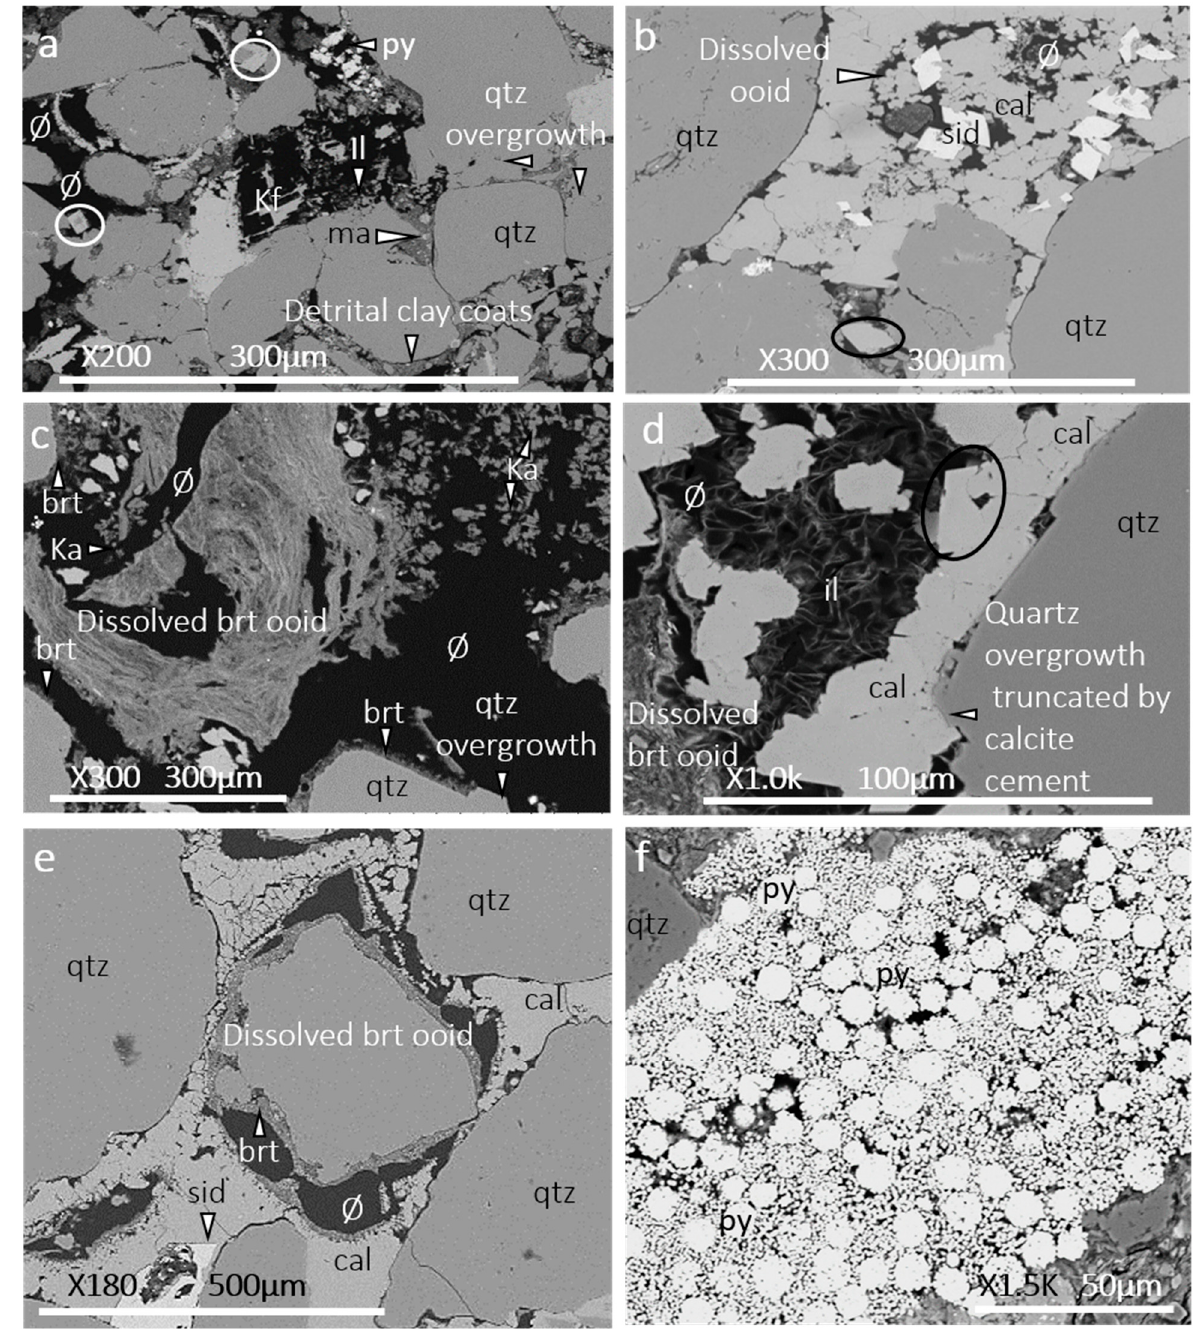
Figure 10. ( a ) BL5 (2211.6 m MD): altered K-feldspar (centre) and dissolved Fe-ooid (top-left) with some compaction to the top-left. Grain contacts show close-packing texture at the centre-right adjacent to detrital clays. ( b ) PW3 (1091.4 m MD): shows where calcite and siderite have replaced a dissolved ooid (top) with the relic of the ooid still visible at the top-right and bottom-left corners of the dissolved grain outline. ( c ) PW3 (1085.1 m MD): relics of a Fe-ooid can be seen in the middle of the photomicrograph while about 30 μ m thick berthierine coats quartz grains to the centre-right, bottom and bottom-left. Kaolinite filled intergranular pore space to the top-right. ( d ) PW3 (1085.1 m MD): pore filling illite can be seen in the centre of the photomicrograph with quartz overgrowths overlying a detrital quartz grain. ( e ) BL5 (2202.2 m MD): dissolved Fe-ooid with relic of cortice forming grain coat. ( f ) PW3 (1098.3 m MD): pore-filling framboidal pyrite aggregates. Definition of abbreviations used on the images: quartz grain (qtz), K-feldspar grain (kf), berthierine (brt), matrix (ma), calcite (cal), siderite (sid), kaolinite (Ka), illite (il), pyrite (py), porosity (Ø.